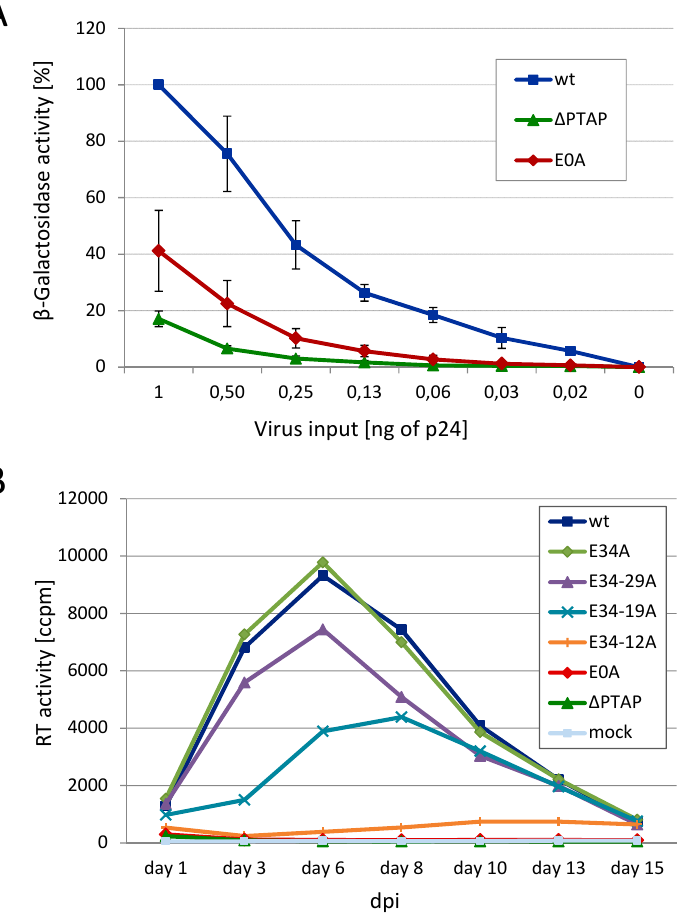
Figure 4. Mutation of glutamic acids reduces the infectivity and replication capacity of HIV-1. ( A ) TZM-bl cells were infected with VSV-G pseudotyped pNL env 1 VLP stocks, standardized for p24. Infectious titers were determined by measuring the β -galactosidase activity. Bars represent the mean values of 3 independent experiments ± SD; ( B ) Infection of human lymphoid aggregate cultures (HLAC) with 1 ng virus standardized for p24 of HIV-1 NL4-3 wt or the respective Glu mutants. Replication was assessed by quantification of the reverse transcriptase activity in cell culture supernatant collected every second or third day post infection (dpi) during 15 days of cultivation.